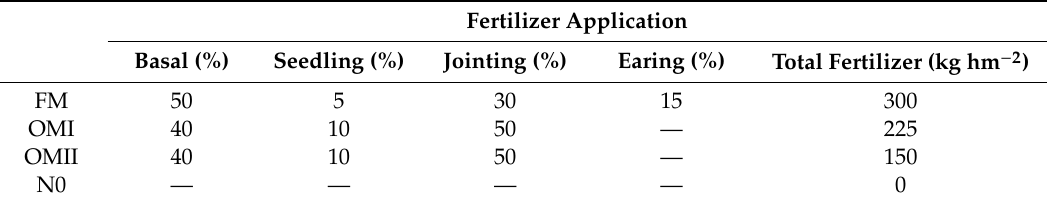
Table 3. Description of fertilization management